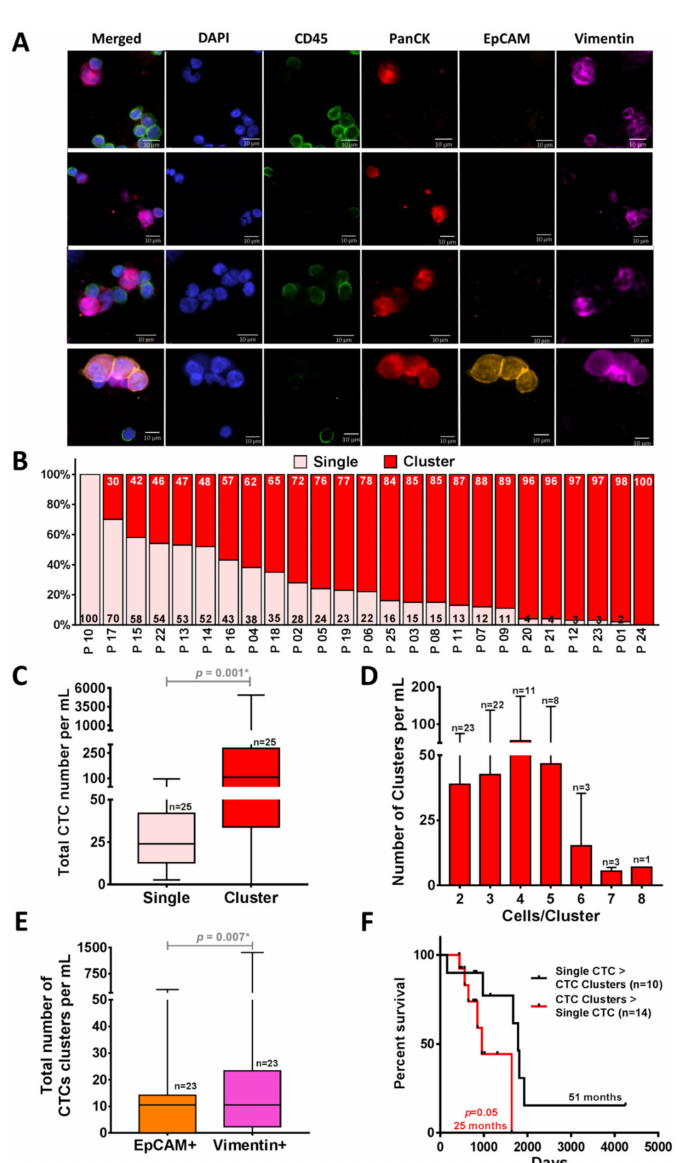
Figure 4. Isolation of CTC clusters from NSCLC patient samples ( n = 25) by using Labyrinth. ( A ) Immunofluorescence staining images of the representative recovered CTC clusters in NCSLC patients. CTC clusters are stained with DAPI (blue), CD45 (green), PanCK (red), EpCAM (orange), and Vimentin (pink). ( B ) The percentage of CTCs in single (light pink) vs. cluster (red) forms. Across all patients, only one patient did not have CTC clusters. ( C ) Comparison between the total CTC numbers in single and cluster forms. Significantly higher numbers of clusters compared to the single CTCs were observed in the captured CTCs from NSCLC patients ( n = 25) ( p = 0.001). ( D ) Cell clusters of 2–8 CTCs were observed in 96% of patients. ( E ) Of the recovered CTC clusters, 41% displayed a mesenchymal or epithelial-to-mesenchymal transition (EMT) phenotype (97 CTC clusters / mL) ( p = 0.007). Wilcoxon test analysis was used for comparing single vs. clusters CTCs and EpCAM + vs. Vimentin + CTCs. Analyses were conducted using GraphPad Prism. ( F ) Comparison of Kaplan–Meier progression-free survival (PFS) graph in patient samples ( n = 24) with a higher number of clusters than single CTCs ( n = 10) (red) and in patients who had a higher number of single CTCs ( n = 14) (black). A higher number of CTC clusters than the single CTCs was correlated with worse PFS ( p = 0.05). Log-rank (Mantel–Cox) tests were used to analyze the Kaplan–Meier